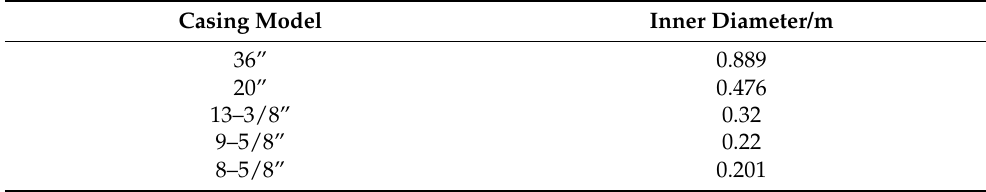
Table 2. Inner diameter of casing for different